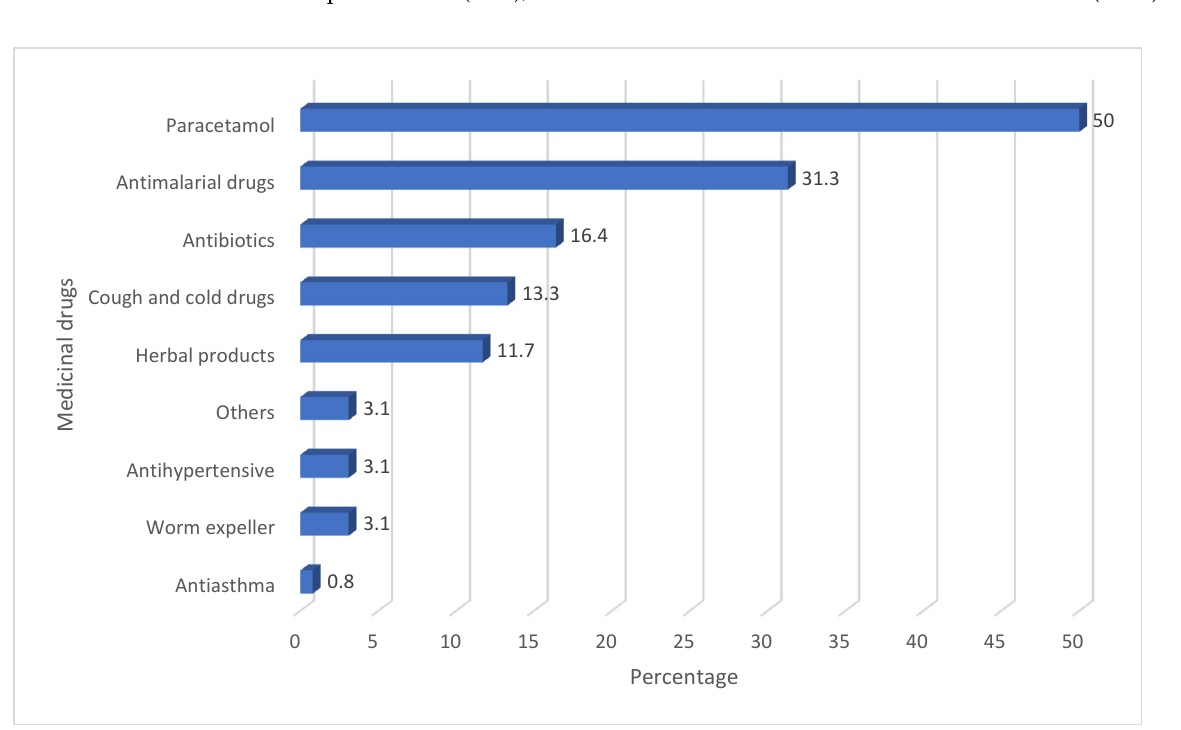
Figure 1. Medicinal drugs used for self-medication during pregnancy.